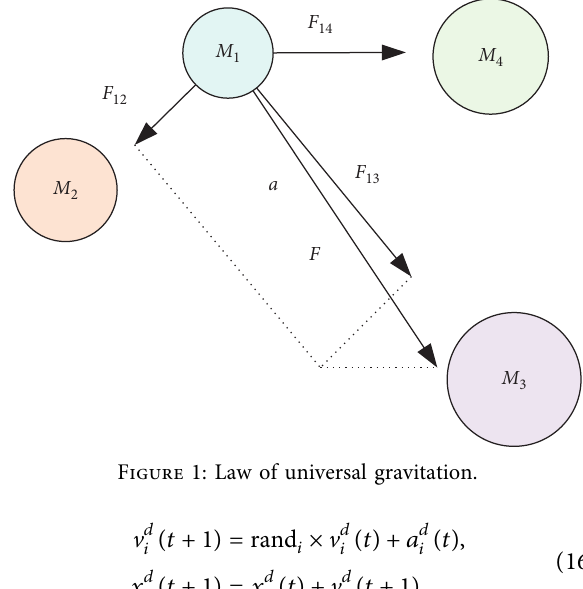
Figure 1: Law of universal